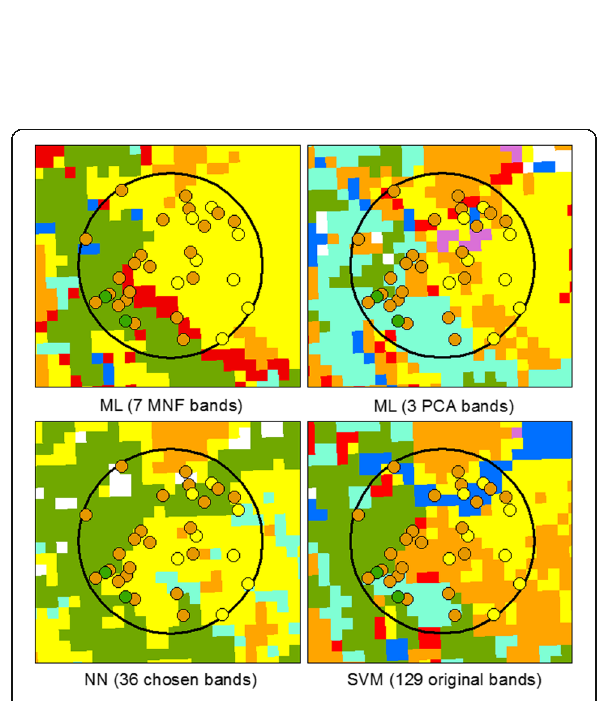
Fig. 5 Comparison of the results of four classification techniques (SVM-129, NN-36, ML-PCA, ML-MNF) on a single sample plot (Alonzo et al. 2014). Legend: red — birch, orange — European beech, yellow — oak, pink — hornbeam, pale blue — European larch, green — Scots pine, dark blue — Norway spruce